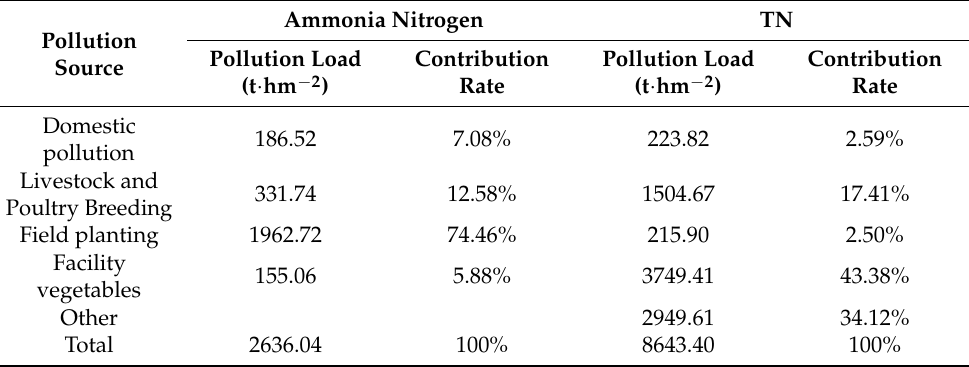
Table 2. Contribution rate of nitrogen source pollution of Mihe alluvial–diluvial fan in